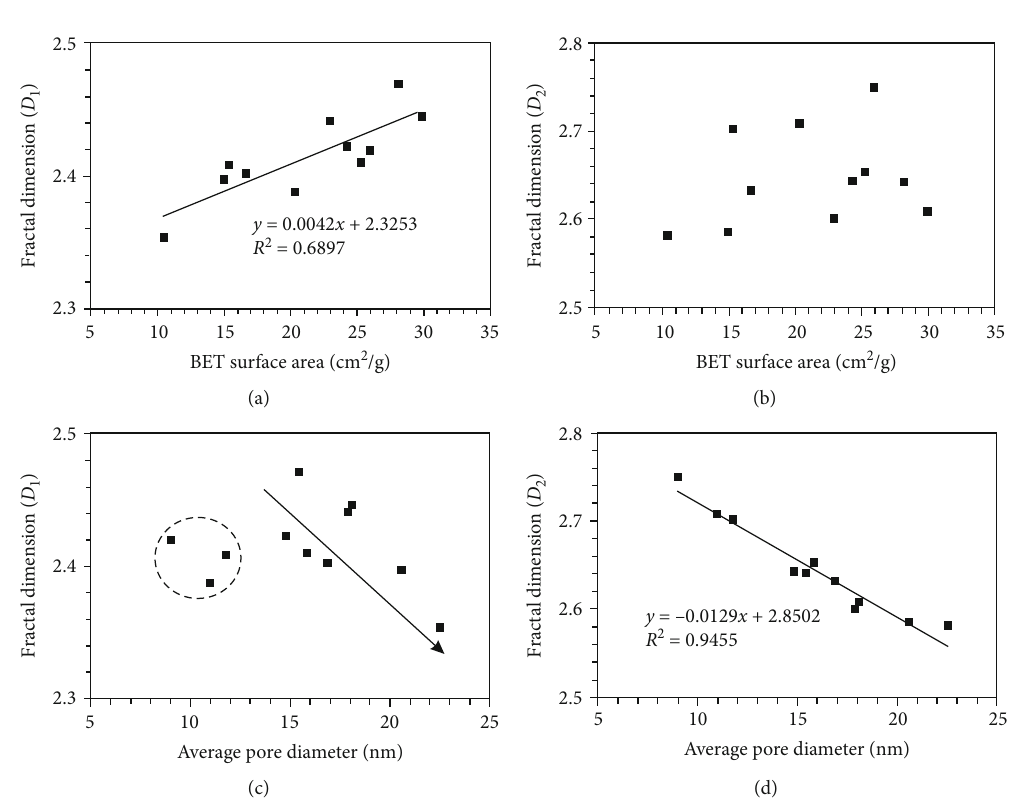
Figure 9: Plots of D and D versus the BET surface area (a, b) and average pore diameter (c, d) of Longmaxi shale 1 2